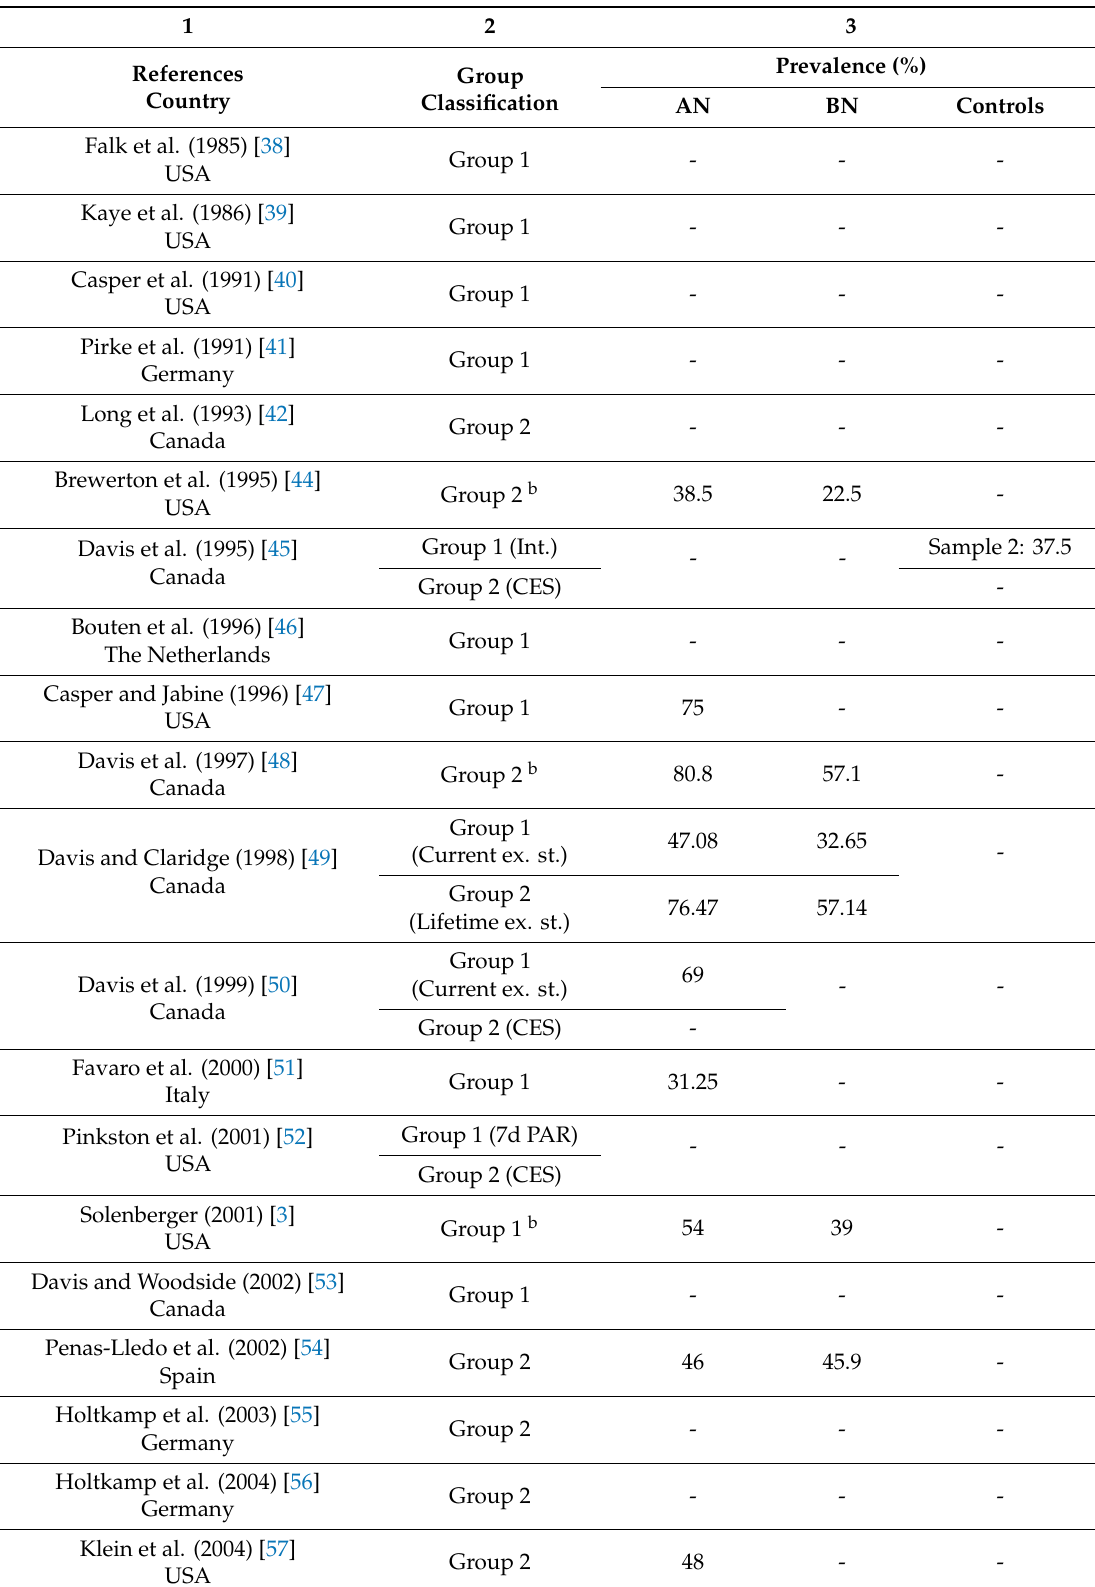
Table 2. Status and group classification of studies in the review and prevalence of problematic use of physical activity and statistical analysis used (columns 1 to